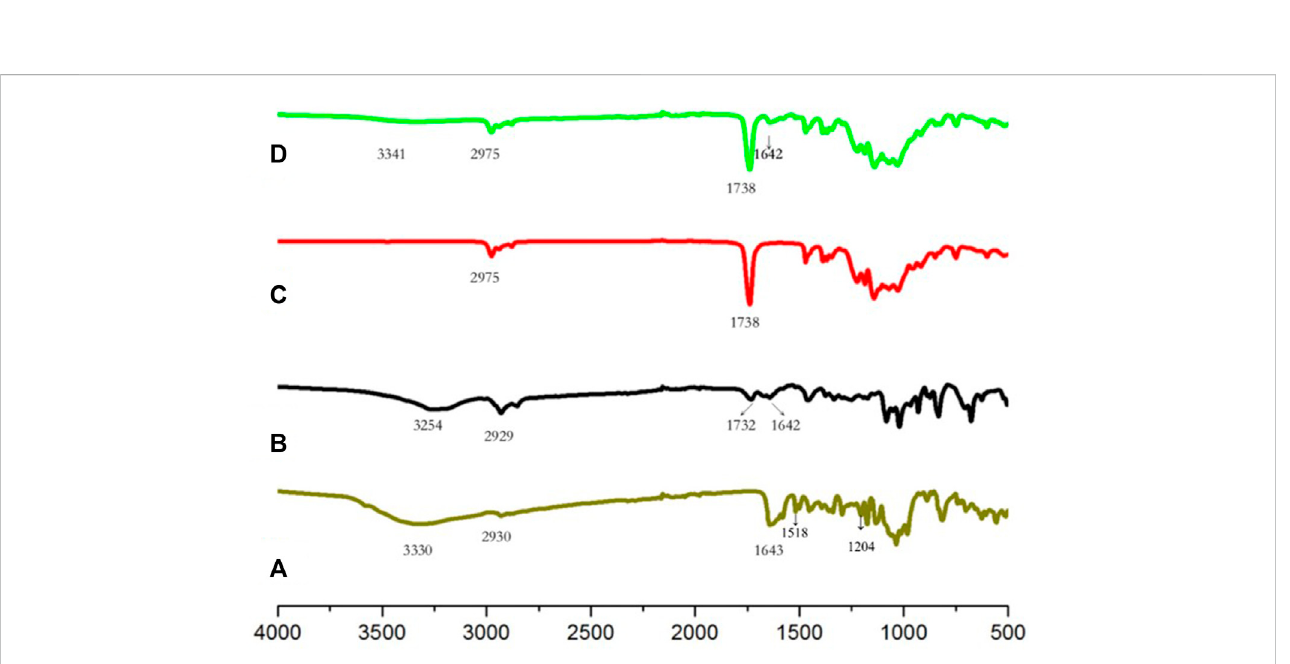
FIGURE 2 FTIR spectra of Naringin (A) , Ng liposomes (B) , SAIB (C) . and Ng-lipo/SAIB (D)